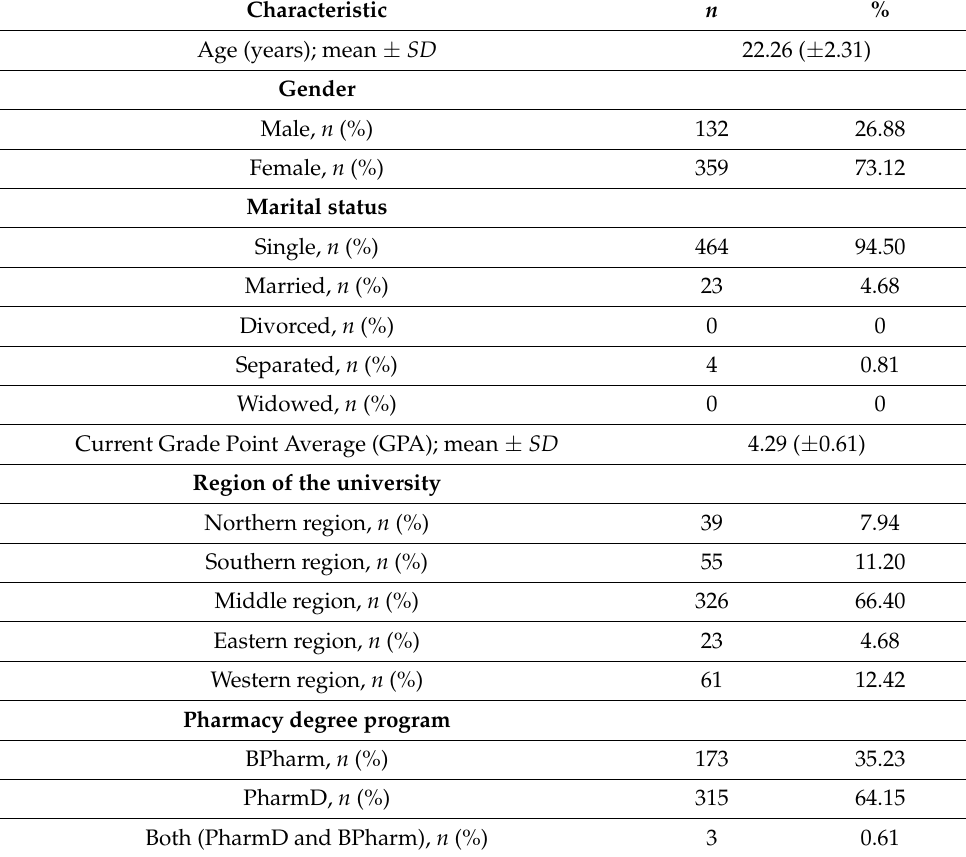
Table 1. Students’ socio-demographic characteristics ( n =